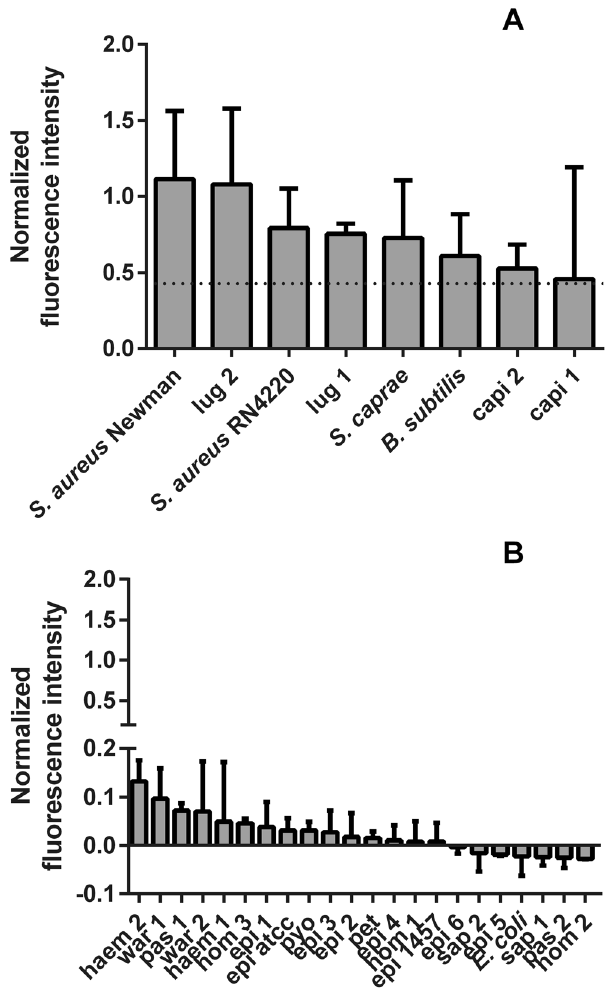
Figure 5. P2&3 TT-probe activiation by different bacterial isolates. ( A ) Normalized fluorescense intensity upon P2&3 TT-probe activation by of all strains that tested positive. B . subtilis was grown in LB and the respective measurements were normalized with LB controls. All other strains were grown in TSB. ( B ) normalized fluorescence intensity of strains that tested negative with the P2&3 TT-probe. E . coli was grown in LB and the respective measurements were normalized with LB controls. All other strains were grown in